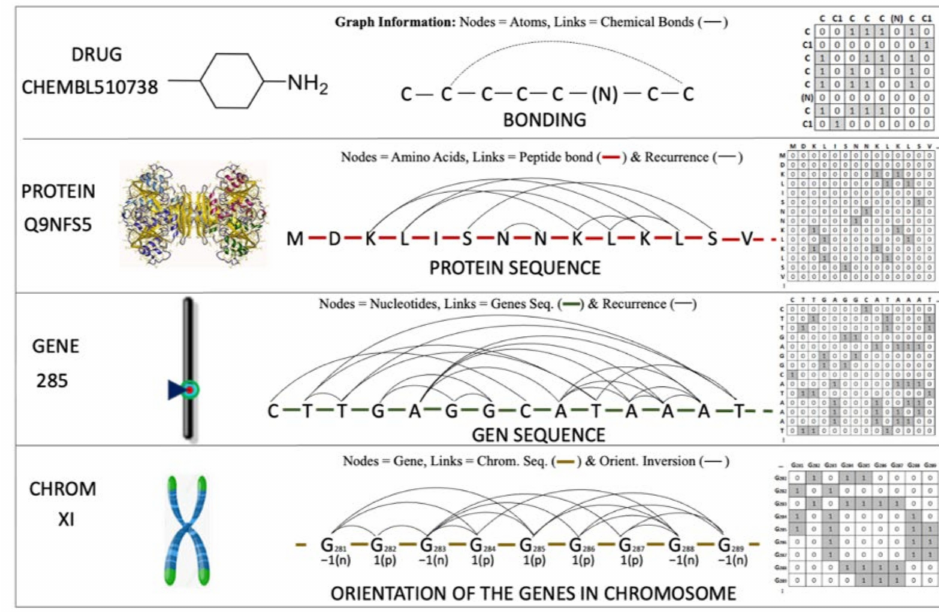
Figure 7. Illustration of different representations to represent multiple molecular